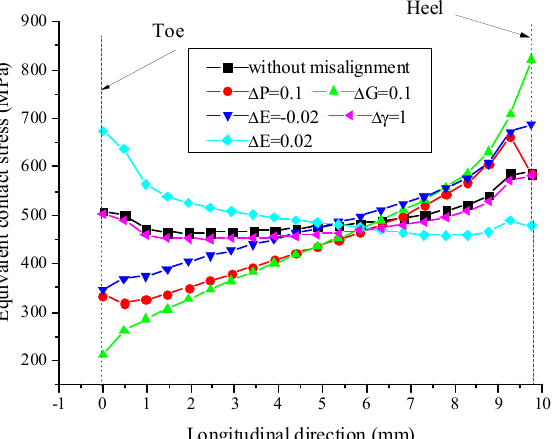
Figure 17. Contact stress distribution for the unmodified driving opinion along tooth width in different installment conditions.